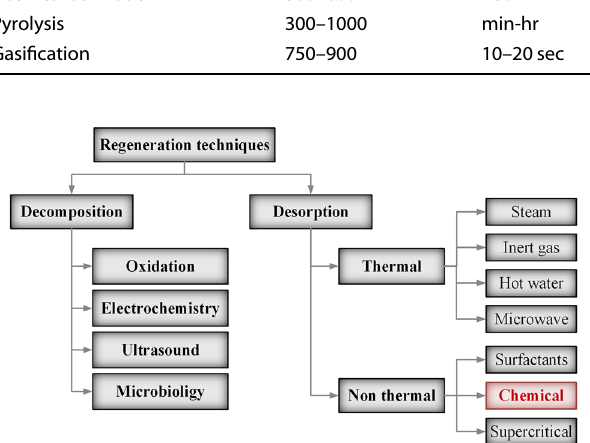
Fig. 2 Different regeneration techniques proposed for adsor- bents ’ reactivation (adapted from ref. 23 ). Common types of decomposition and desorption techniques have been widely applied to regenerate contaminated adsorbents.